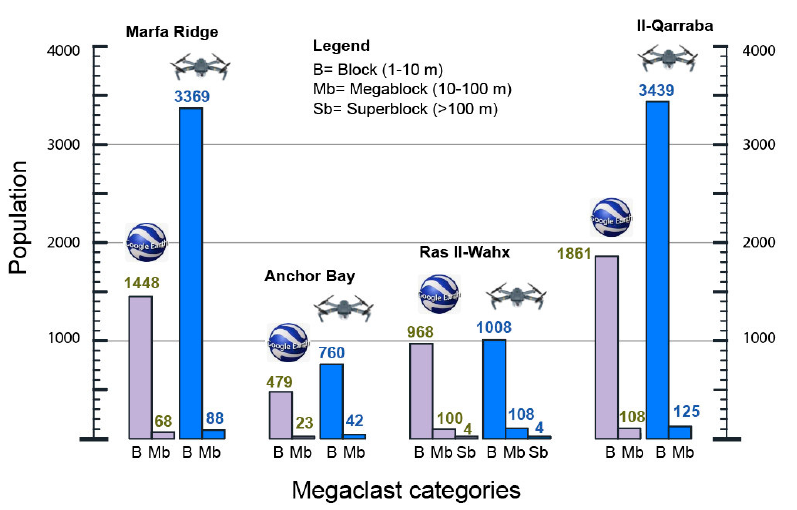
Figure 16. Megaclast populations according to the methodology proposed by Bruno and Ruban [55] using GE analysis and UAV-DP outputs.